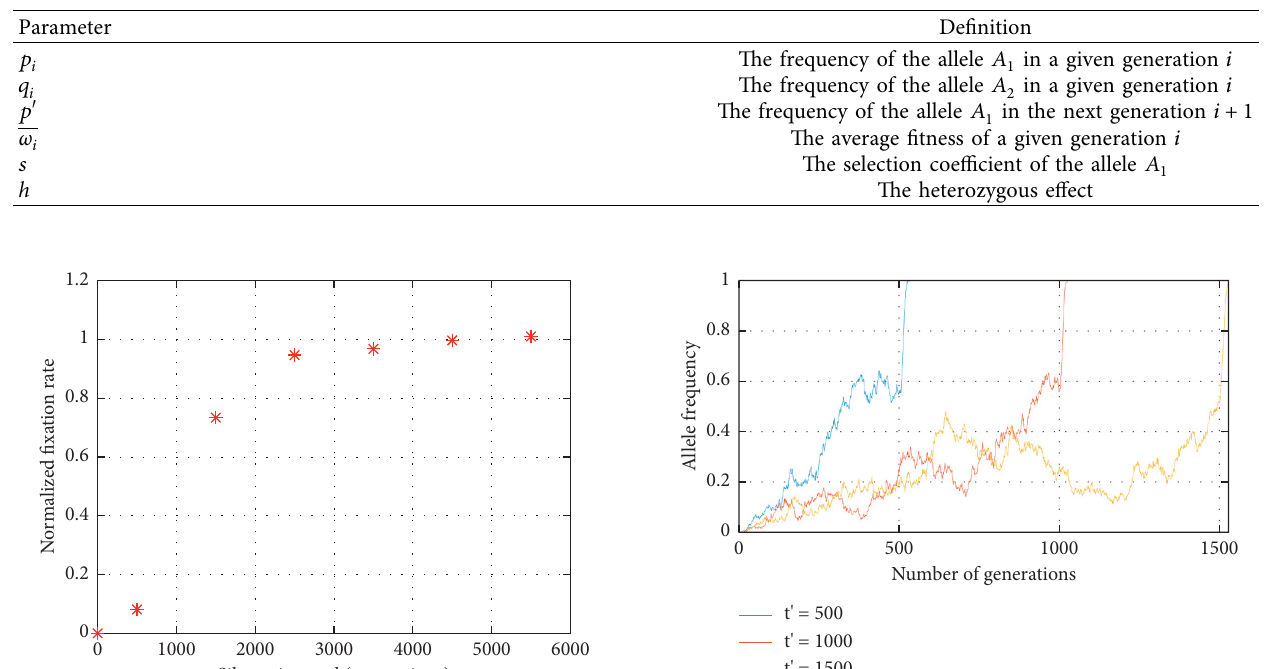
Table 3: Model parameters.